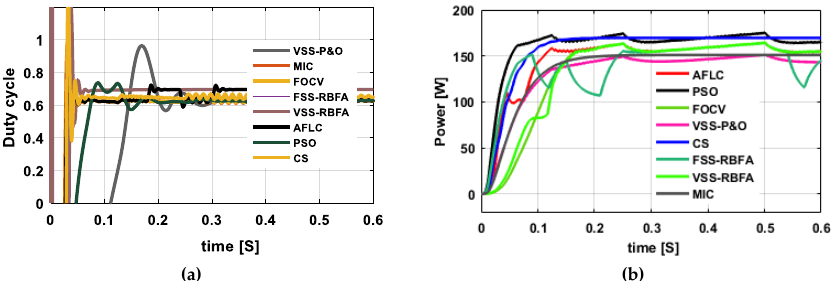
Figure 14. ( a ) Duty cycle and ( b ) output power of a conventional boost converter (CBC) by applying different MPPT techniques at 800 W/m 2 .